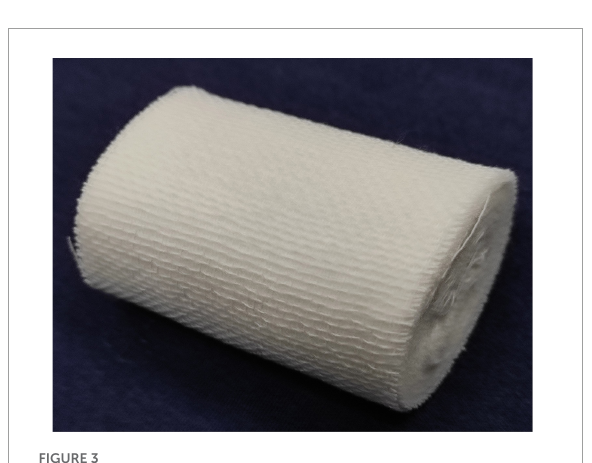
FIGURE4 Compression upon distal transradial artery for